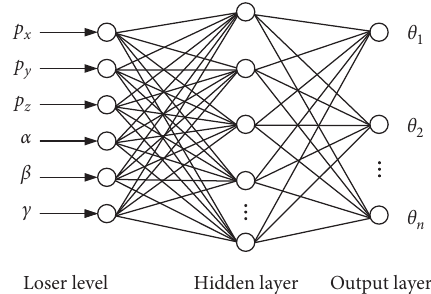
Figure 2: RBF neural